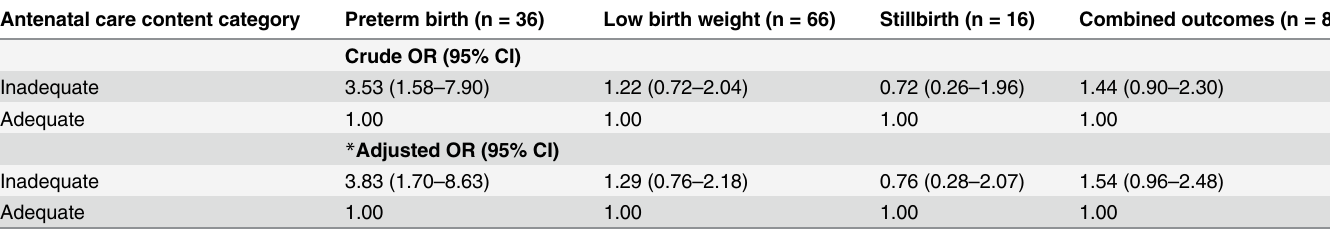
Table 4. Antenatal care content adequacy and pregnancy outcomes (n =